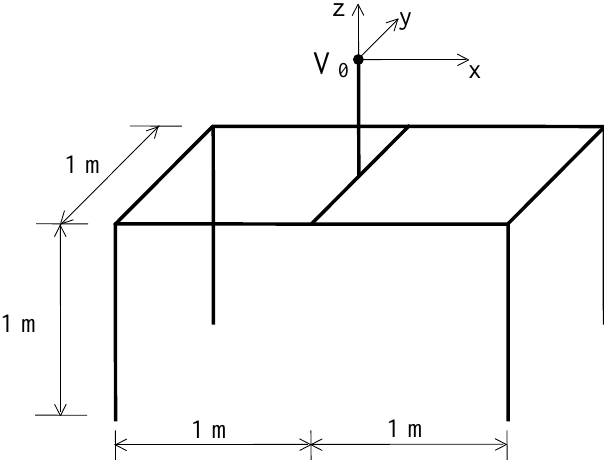
Figure 2. Three-dimensional geometry of the active GS.